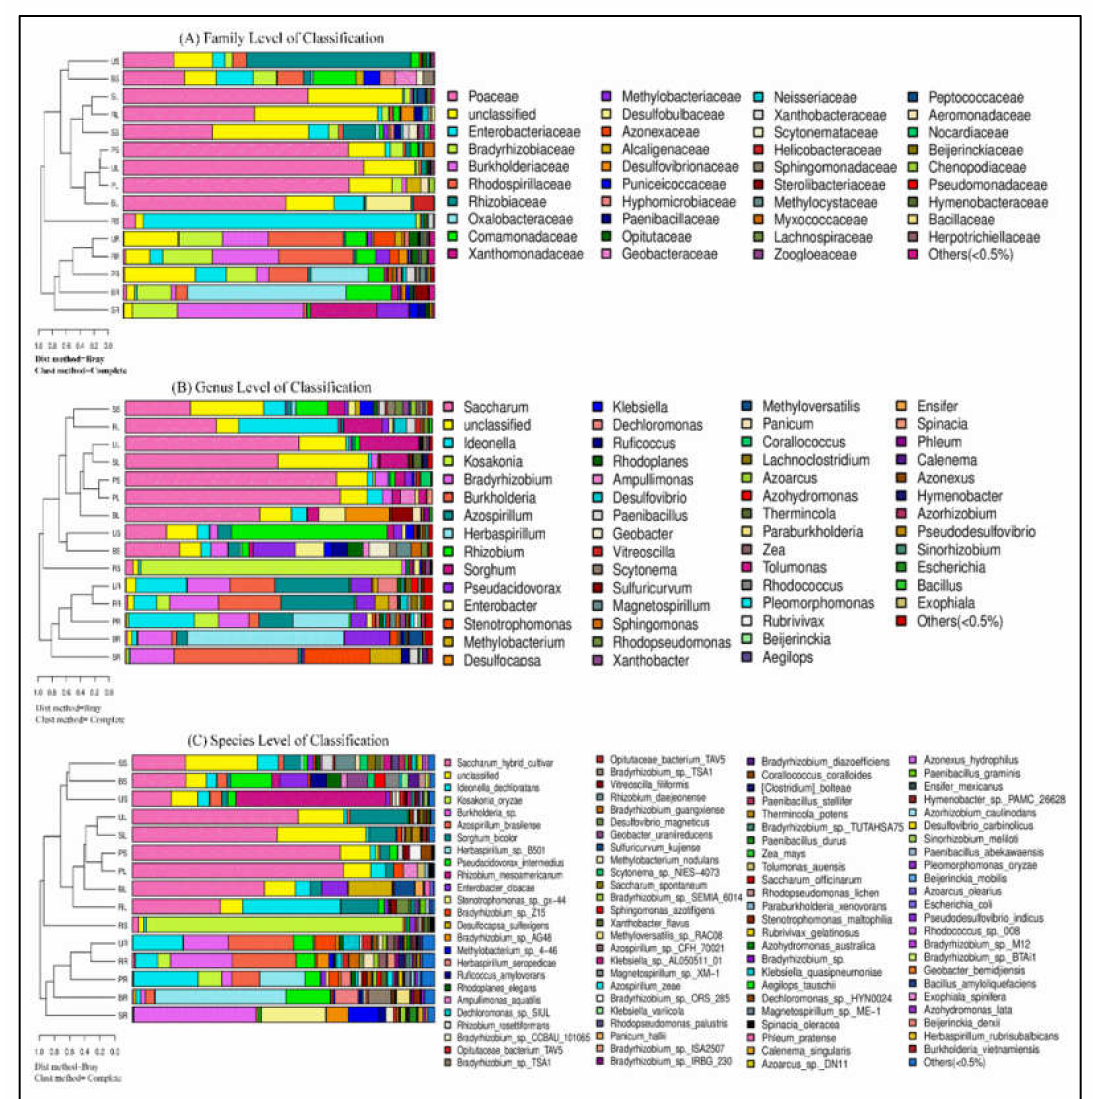
Figure 6. Combined analysis of similarity tree and histogram. ( A ) Family level of classification, ( B ) genus-level of classification, and ( C ) species-level of classification. On the left is the hierarchical clustering analysis (Bray–Curtis algorithm) based on community composition among the samples and on the right is the histogram of the community structure of the